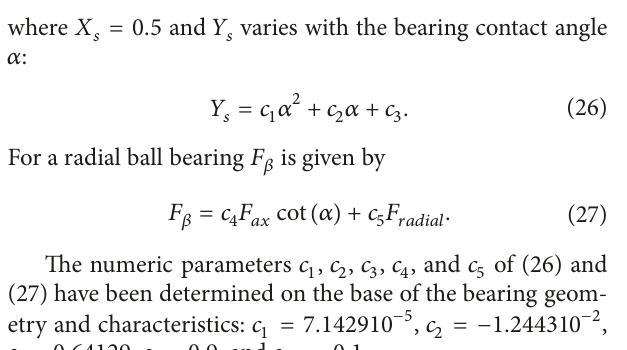
Figure 9: Experimental apparatus; from left to right: axial actuator, NDE radial magnetic bearing, speed sensor, DE radial magnetic bearing, magneticthrustbearing, and power transmission